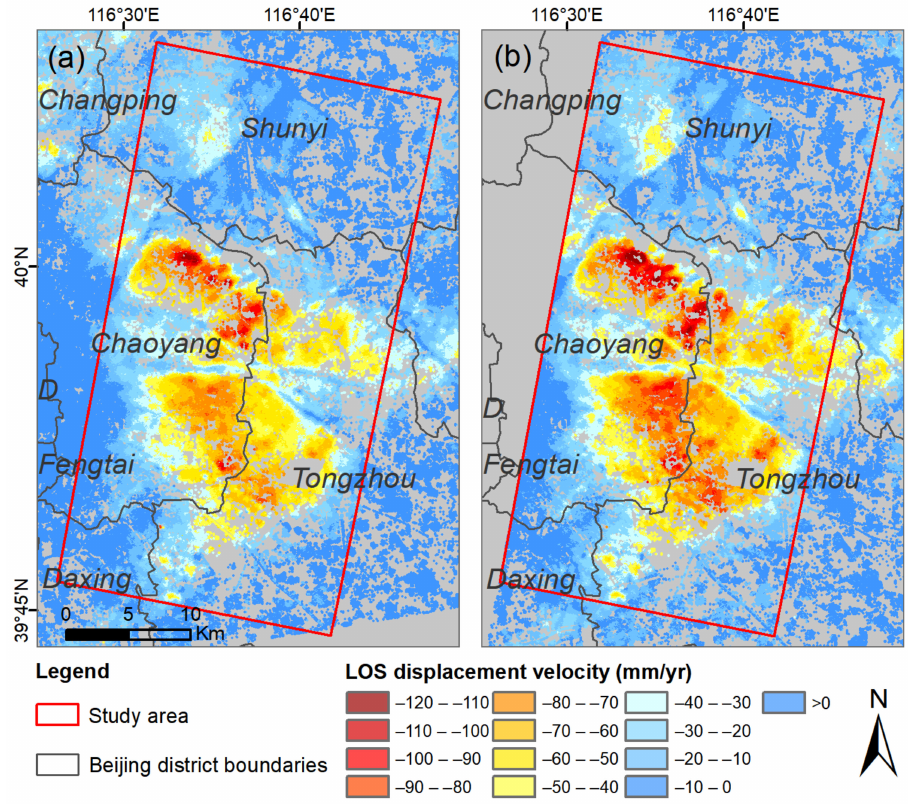
Figure 4. Annual LOS displacement maps from Sentinel-1. ( a ) PS-InSAR result of the ascending dataset; ( b ) PS-InSAR result of the descending